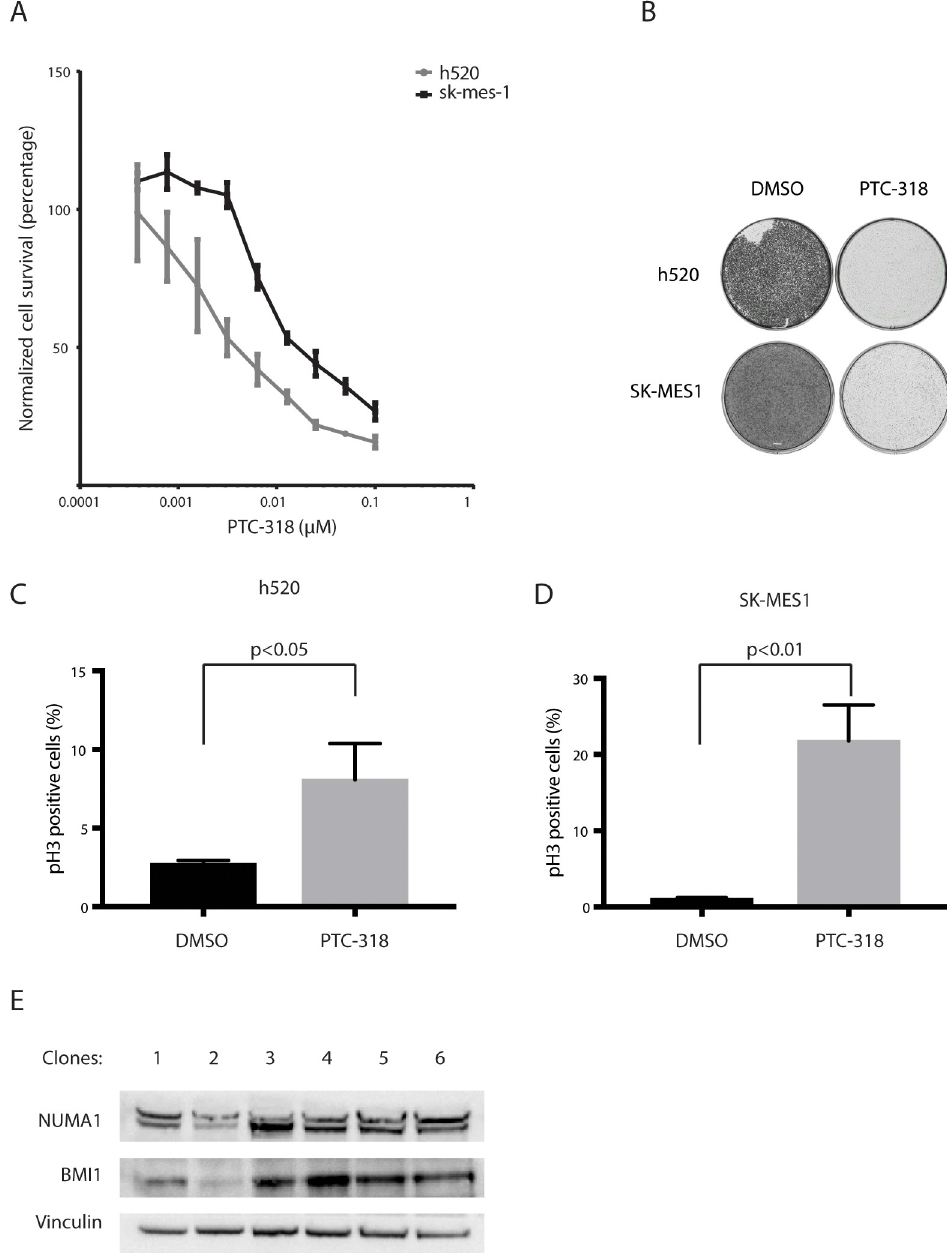
Fig 5. Non-small cell lung cancer cell lines are sensitive to BMI1 inhibition. (A) IC50 measurements of NSCLC cell lines h520, SK-MES-1, and SWI-1573. The x-axis shows the PTC-318 concentration in μ M and the y-axis the percentage of surviving cells relative to non-treated control counterparts. (B) Colony formation of h520 and SK-MES-1 cells treated with either 0.1% DMSO or 40 nM (h520) or 80 nM (SK-MES-1) of PTC-318. (C) Percentages of h520 phospho-histone H3 populations after treatment with either 0.1% DMSO or 40 nM PTC-318 determined by flow cytometry quantification. (D) Percentages of h520 phospho-histone H3 populations after treatment with either 0.1% DMSO or 80 nM PTC-318 determined by flow cytometry quantification. Error bars represent SD (n = 3). A two-tailed Student’s t-test was performed for statistical testing. (E) Protein expression of NUMA1 and BMI1 in NUMA1-WT clones of an h520 population transfected with Cas9 targeting BMI1, single-cell sorted, and expanded.